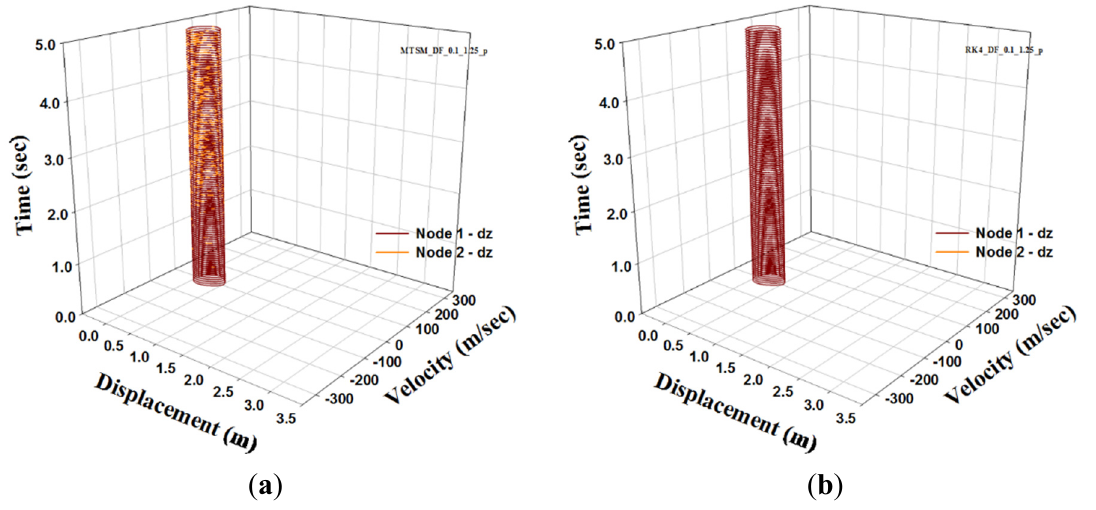
Figure 11. Phase diagram of DFN model. (Perfect case): ( a ) TSM; ( b ) RK4.